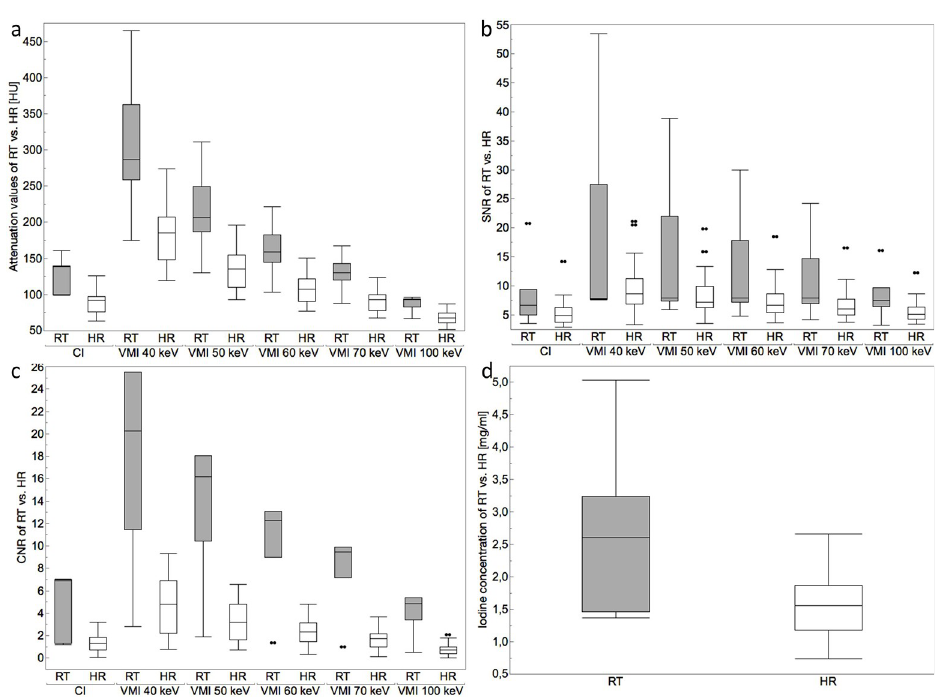
Fig 1. Illustrations of mean attenuation values (HU), signal-to-noise ratio (SNR), contrast-to-noise-ratio (CNR) and iodine concentration [mg/ml] reveal significantly higher values in residual tumor (RT) as compared hyperemic rim (HR) (a–d). Furthermore, attenuation and CNR were significantly higher in low-keV VMI compared to CI (a, c).